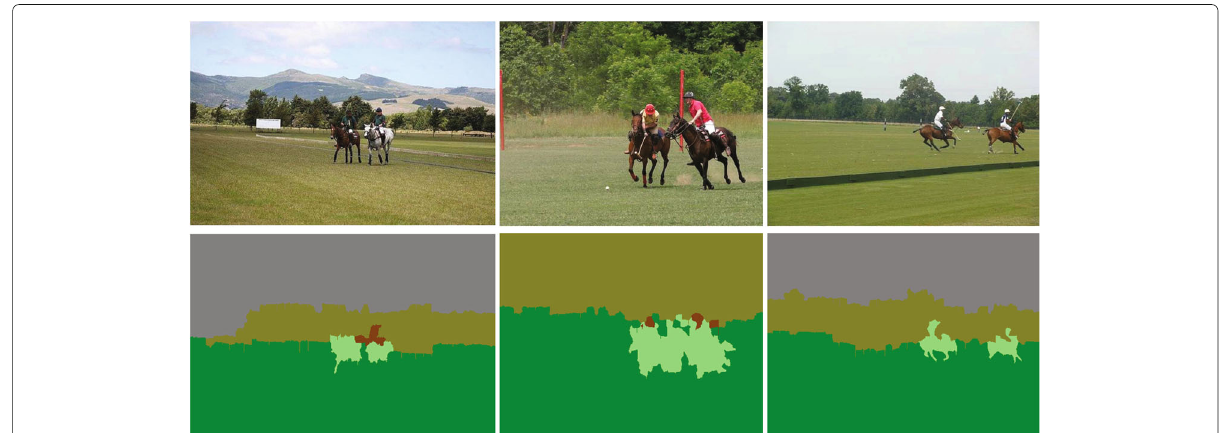
Fig. 6 Examples of scene-level labeling result on Polo dataset. Best viewed in color